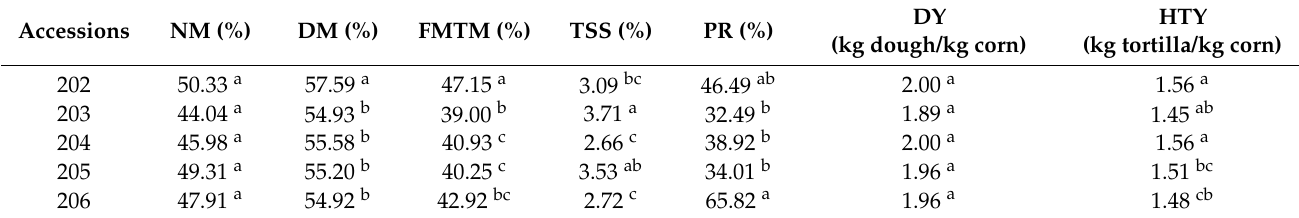
Table 5. Nixtamal and tortilla quality made of native maize from the Jalisco Highlands,